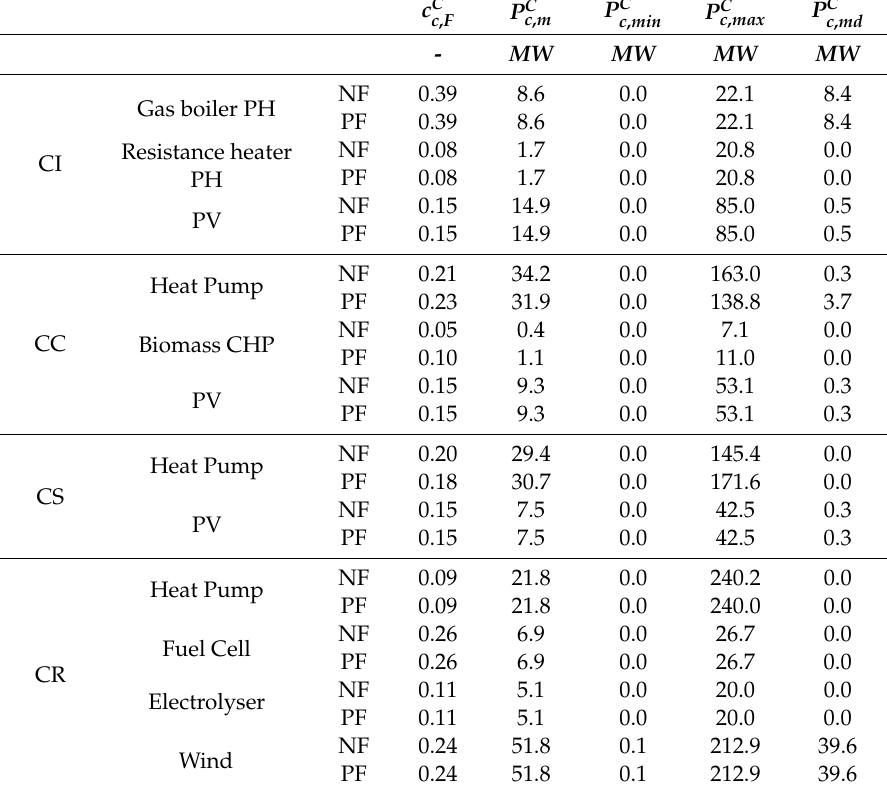
Table 7. Statistical analysis of the conversion unit and RES timeseries.